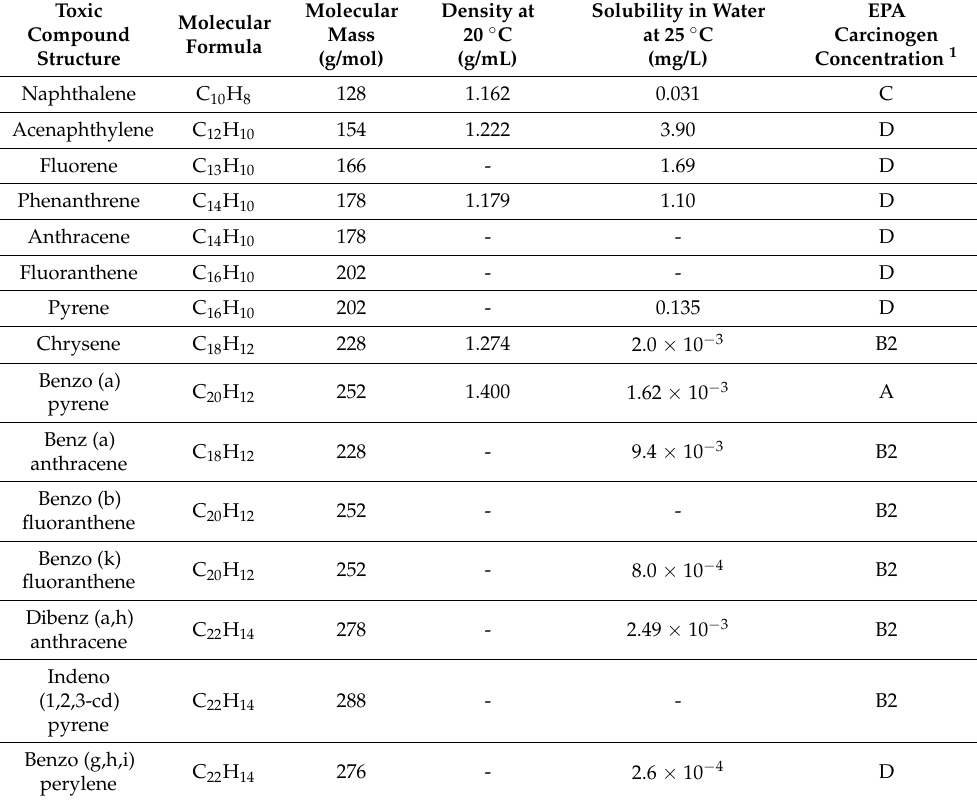
Table 3. The physical and chemical composition of polycyclic aromatic hydrocarbons (PAHs). Toxic